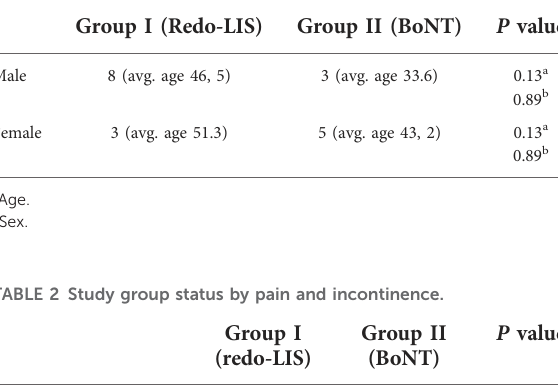
TABLE 1 Study group status by age and sex.